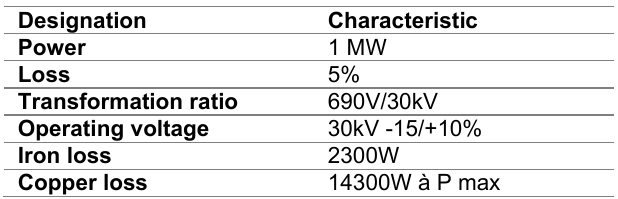
Table 13. Power transformer technical specifications